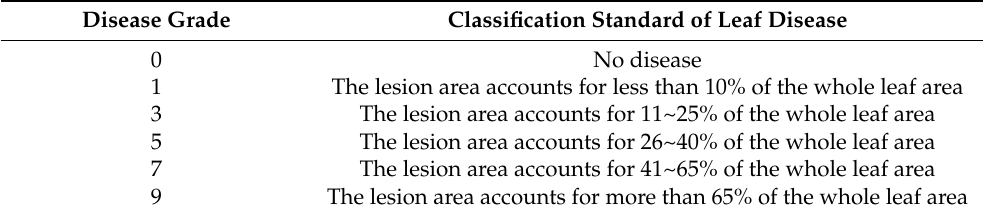
Table 6. Grading table of disease spots on apple